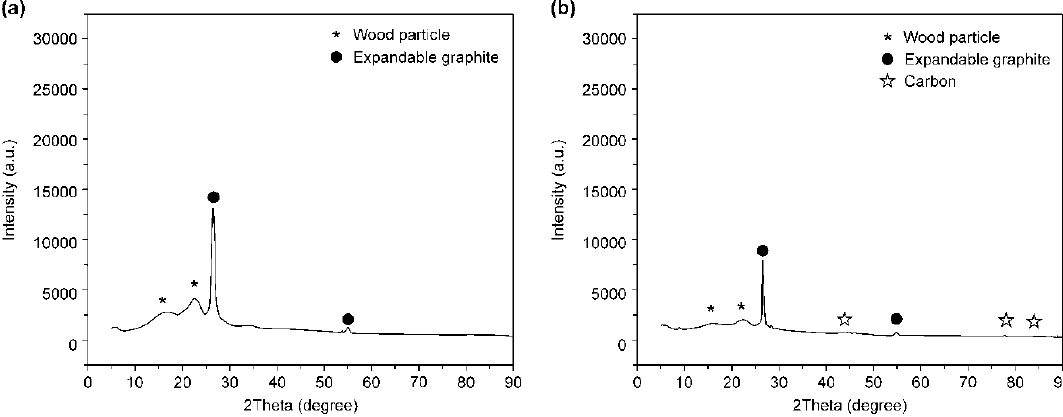
Figure 4. XRD analysis of the EG 30 wt.% composite specimen ( a ) before and ( b ) after combustion.